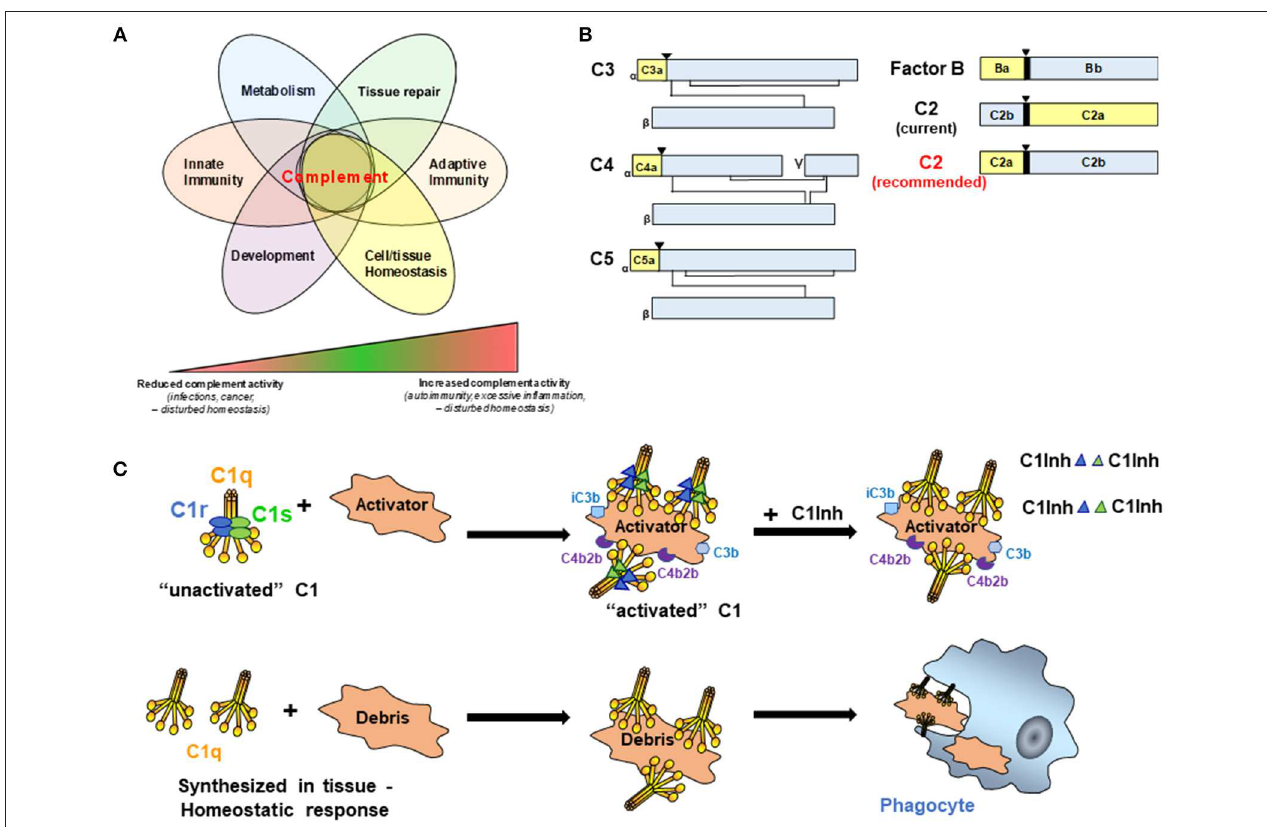
FIGURE 1 | (A) Complement activities control key cellular processes and contribute to a broad range of disease states. It is now broadly acknowledged that complement functions well beyond mere protection against invading pathogens but participates actively in the control of key physiological processes. Therefore, complement is key to normal cell and tissue homeostasis and aberrant complement activation (either too little or too much) can hence cause or contribute to a broad range of disease settings including recurrent infections and cancer (too little) or auto-immunity and fibrosis (too much). (B) Schematic representation of C3 family members, FB, and C2. While convention holds that smaller fragments (yellow for C3, C4, C5, and FB) retain earlier letters than larger fragments (Blue for C3, C4, C5, and FB), C2 breaks with convention (C2 current). To facilitate communication in the field and better standardize complement nomenclature, we recommend adopting standard convention for C2 (C2 recommended). ( H ) Indicates cleavage site for liberation of smaller fragment. (C) C1 is a complex macromolecular structure consisting of C1q, C1r, and C1s. C1 circulates in blood as an “unactivated” complex of the recognition protein, C1q (yellow), and two molecules each of the proenzymes C1r and Cls (blue and green ellipses). Conformational changes induced by binding to an activator result in activated C1 due to the conversion of C1r and C1s to active serine proteases (blue and green triangles). C1s proceeds to cleave C4 and C2 which results ultimately in the formation of the classical pathway C3 convertase, C4b2b. Generation of opsonic C3b and iC3b, and subsequently C5a and C5b-9 (not shown) mediate the possible complement effector functions that follow. Four C1-INH molecules per C1 (only representative complexes are shown) are required to inactivate the serine proteases, C1r and C1s, and results in their dissociation from C1q, thereby regulating the amount of C4b2b generated. In the lower row, C1q can be synthesized in tissue to “silently” eliminate apoptotic cells and cellular